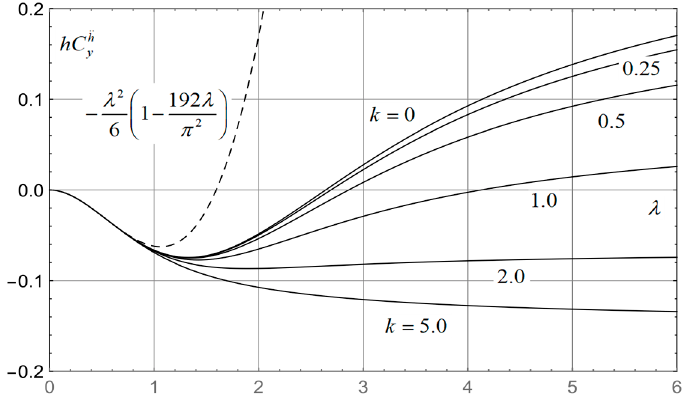
Figure 3. Derivative h